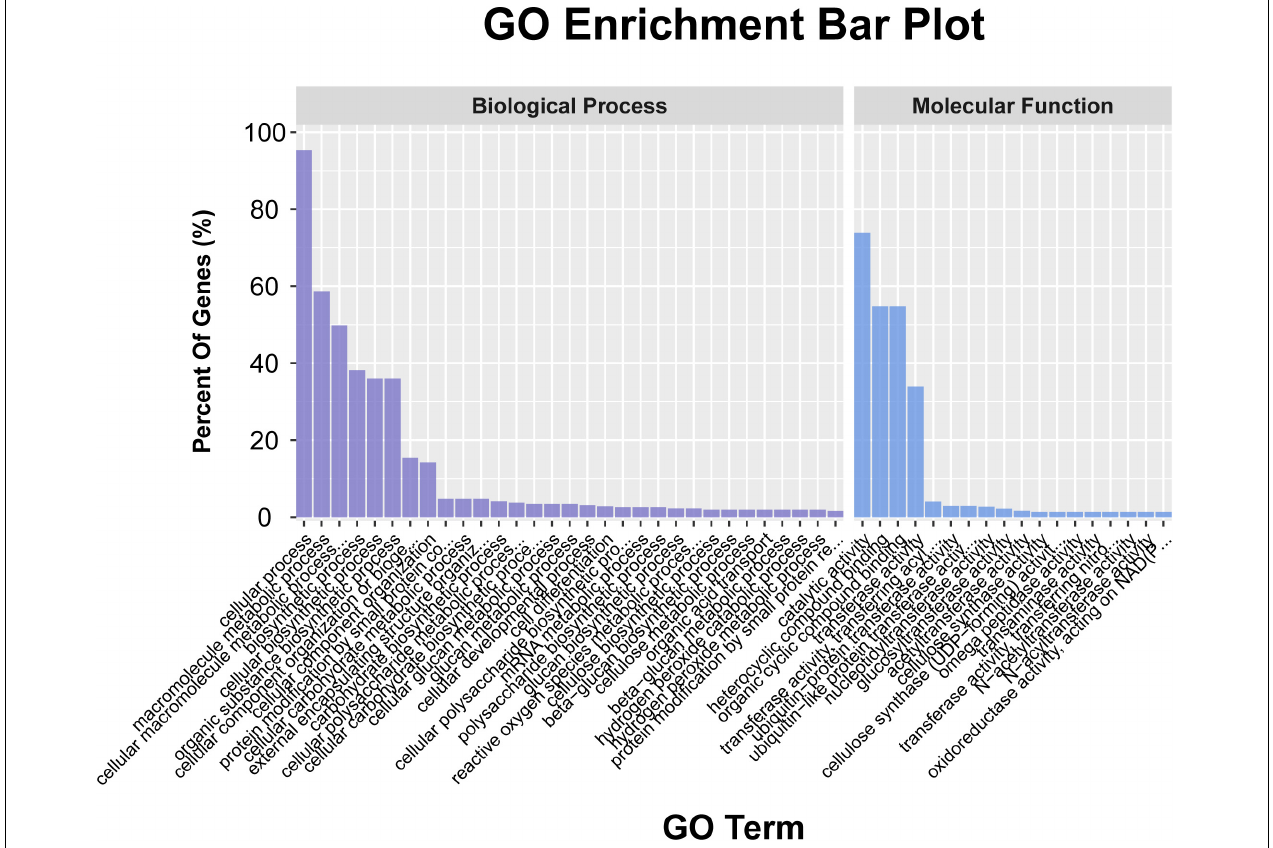
FIGURE 4 | The annotation of the candidate genes in the ten quantitative trait loci (QTL) through gene ontology (GO)